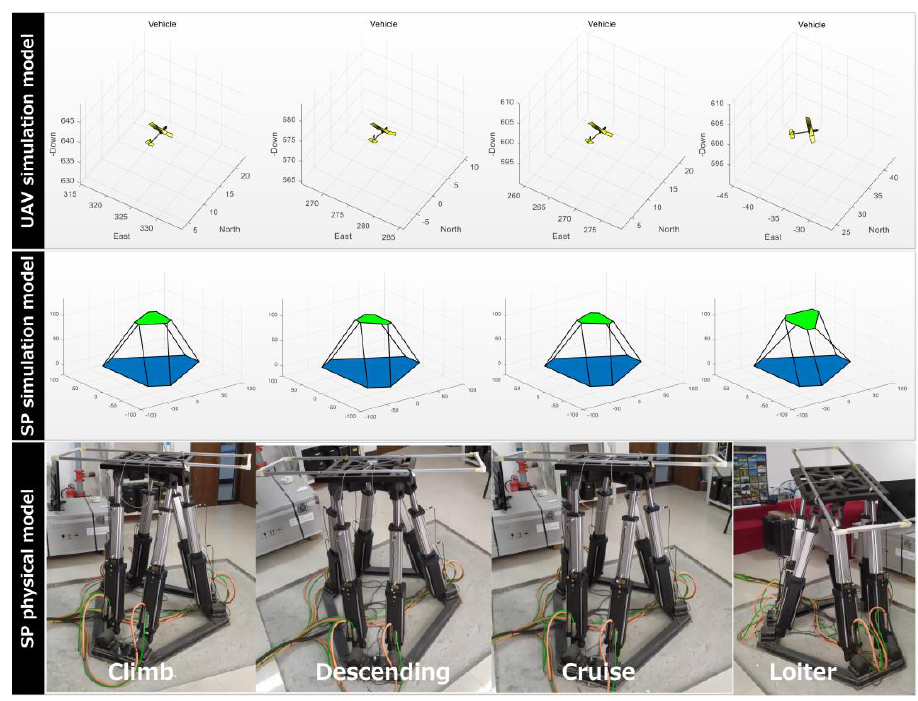
Figure 19. UAV-SP co-simulation in different flight phases.